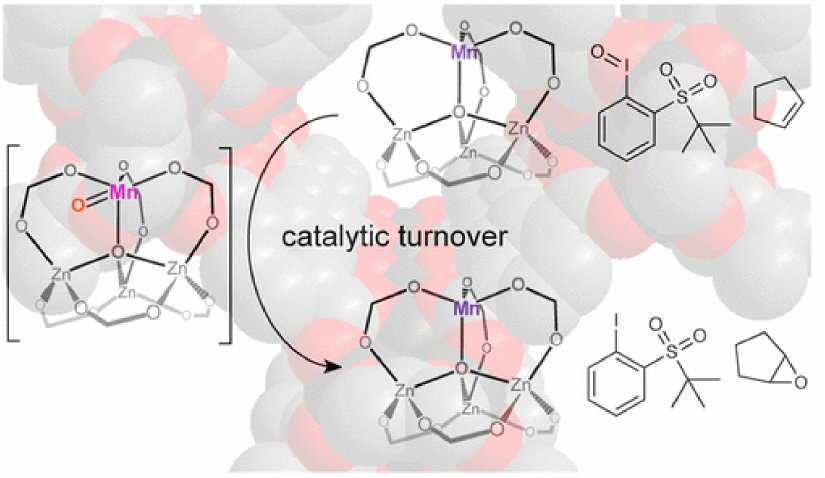
Figure 5. Schematic view of the selective catalytic activity of MnFe-MOF-74 for the epoxidation of the cyclic alkenes in the presence of t BuSO 2 PhIO. Reprinted with permission from ACS Catal., 2018, 8, 596–601 ([166]). Copyright 2018 American Chemical